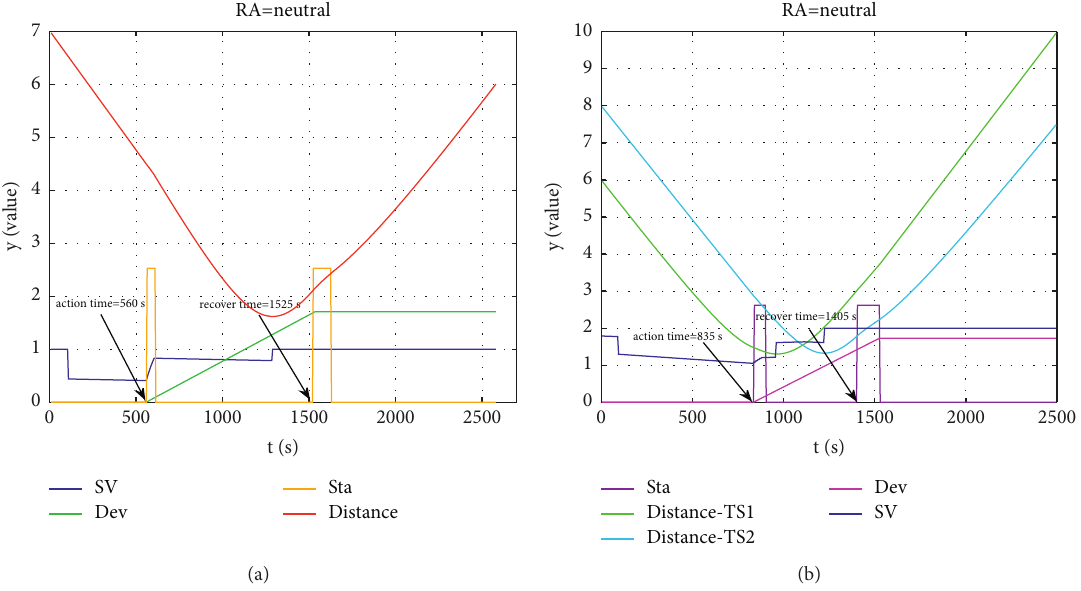
Figure 11: Results of decision indicators with neutral officers in (a) scenario I and (b) scenario